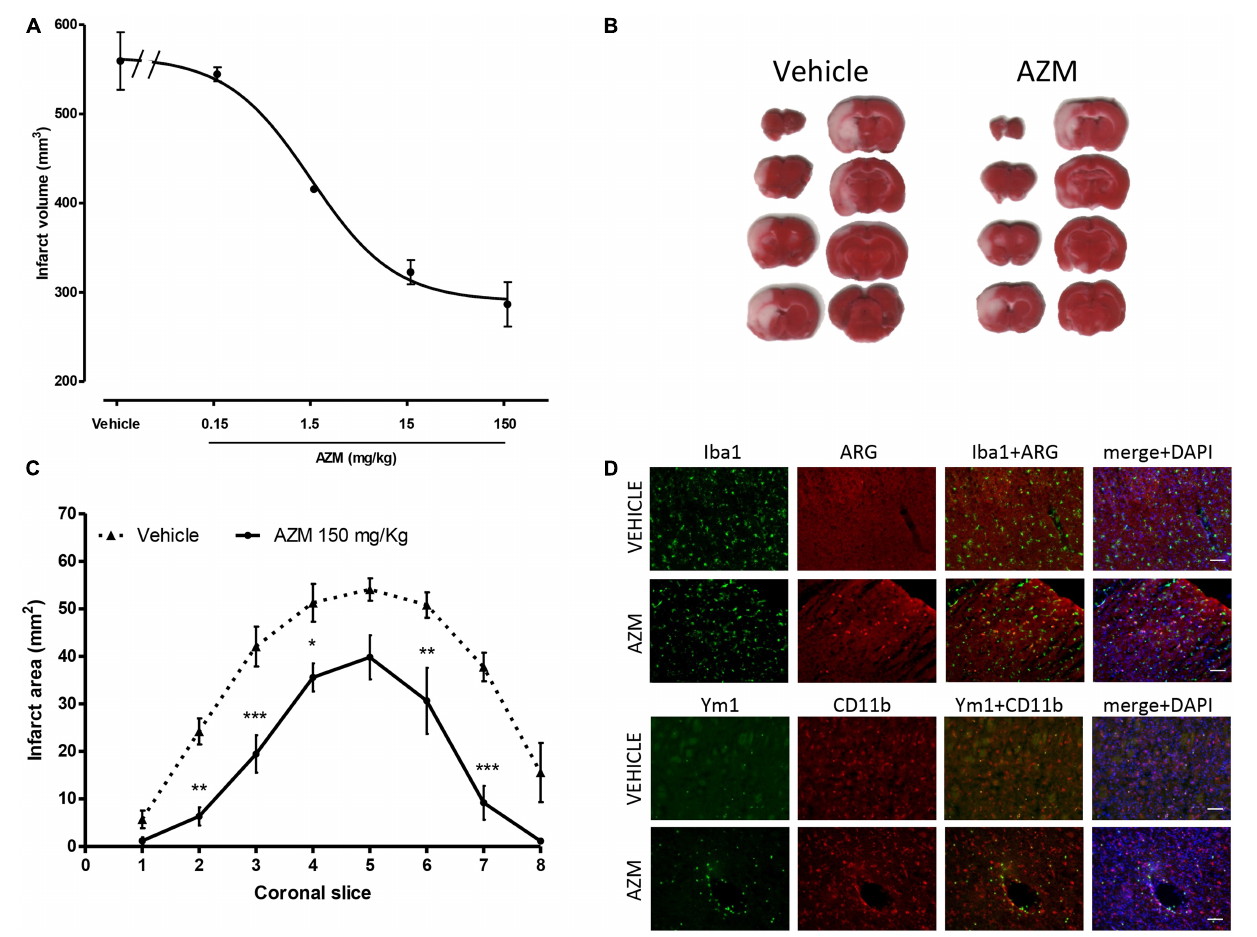
FIGURE 1 | Neuroprotective properties of azithromycin in rats subjected to 2 h MCAo followed by 22 h of reperfusion. (A) Intraperitoneal administration of a single dose of azithromycin (AZM, 0.15–150 mg/kg) upon reperfusion results in a dose-dependent (ED 50 = 1.40 mg/kg; 95% CI = 0.48–4.03) reduction of ischemic brain damage measured after 22 h of reperfusion ( n = 4–6 animals per experimental group). (B) Representative TTC-stained coronal brain sections and (C) corresponding values of ischemic areas in rats subjected to transient MCAo and injected i.p. with vehicle (0.9% NaCl) or AZM (150 mg/kg) upon reperfusion ( ∗ P < 0.05, ∗∗ P < 0.01, and ∗∗∗ P < 0.001 vs. corresponding vehicle, ANOVA for repeated measures followed by Bonferroni post-test). (D) Representative immunofluorescence images of the ischemic frontoparietal cortex (upper set of panels) and striatum (lower set of panels) of rats injected with vehicle (0.9% NaCl) or AZM (150 mg/kg) i.p. upon reperfusion. Brain tissue slices were stained for Iba1 (to label microglia/macrophages) or CD11b (to label microglia/macrophages and neutrophils) and arginase 1 (ARG) or Ym1 (markers of the M2 phenotype), whereas, nuclei were counterstained with